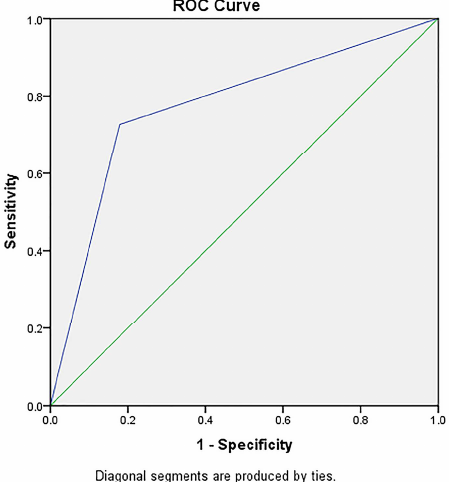
Figure 5. AUC for Model 2 using 3 parameters (the preoperatively estimated pancreatic remnant volume, the main pancreatic duct diameter, the unenhanced liver density).